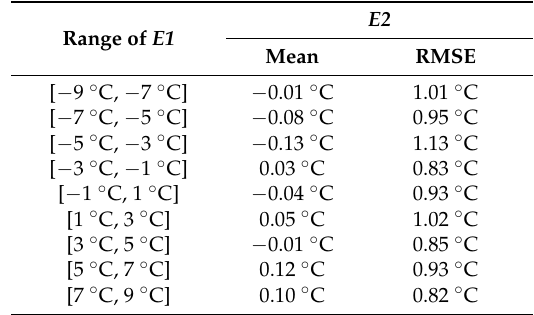
Table 2. Uncertainty analysis for the relative temperature difference. E1 is the error between absolute water temperatures of one point estimated with original atmosphere parameters and simulated atmosphere parameters. E2 is the error between water temperature differences of two points estimated with original atmosphere parameters and simulated atmosphere parameters.